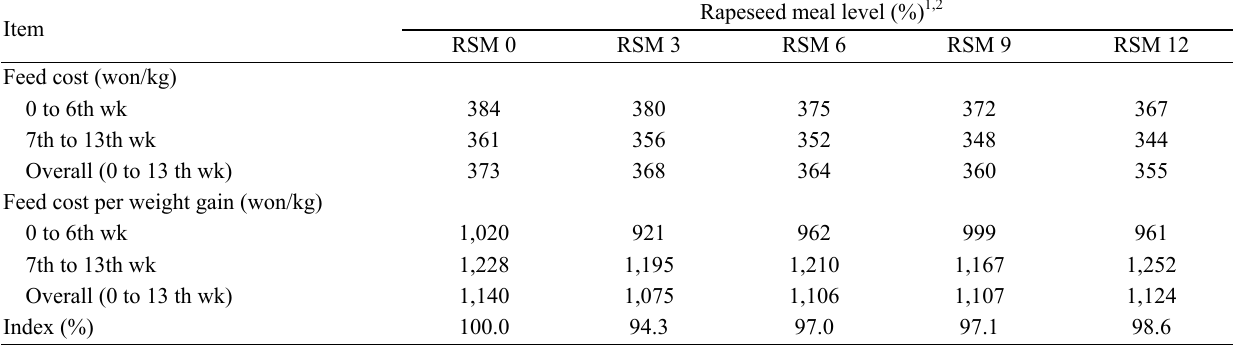
Table 10. Influence of dietary rapeseed meal (RSM) on economic benefits in growing-finishing diets